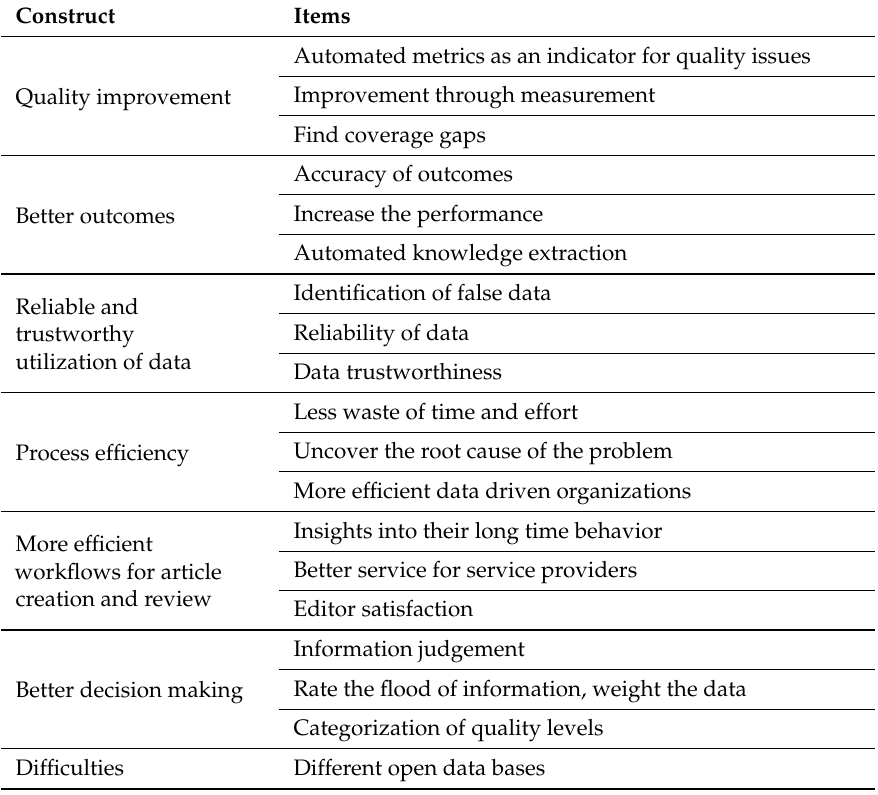
Table 2. Constructs and items of the designed